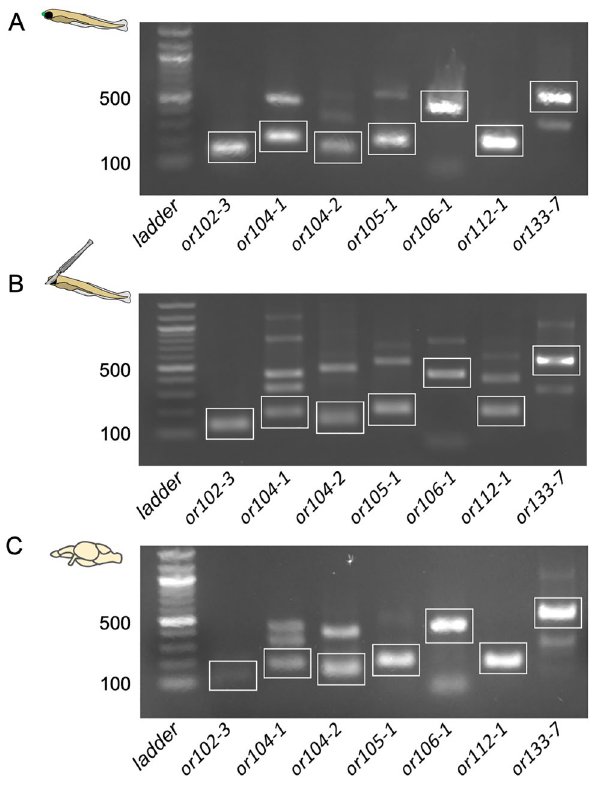
Figure 4. RT-PCR amplification of 7 olfactory receptor gene transcripts in non-olfactory tissues in larval and adult zebrafish. ( A ) or102-3, or104-1, or104-2, or105-1, or106-1, or112-1 and or133-7 genes are expressed in the whole 6-day-old zebrafish larvae. ( B ) All 7 OR gene transcripts are amplified in larvae without nose. 6-day-old Tg(OMP: YFP) larvae were used to ascertain the complete removal of the olfactory epithelium. ( C ) All tested OR gene transcripts are detected in the adult zebrafish brain. 100 bp ladder is used. Cartoons on left depict conditions for tissues used for RT-PCR. Green dot on rostral part of larva ( A ) represents OMP:YFP expressing olfactory epithelium, which was removed for ( B ). White boxes outline bands that correspond to the expected size. Original non-cropped images are in Fig.